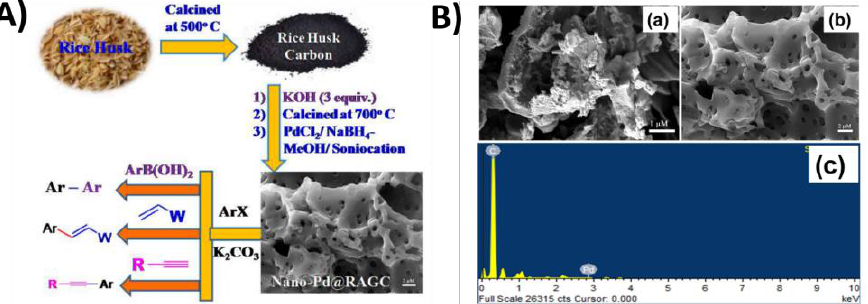
Figure 24. ( A ) Fabrication of nano-Pd@RAGC (from rice husk biomass-derived chemically activated mesoporous graphitic carbon) and its applications in cross-coupling reactions; ( B ) FESEM images of biomass-derived carbon ( a ) before KOH activation and ( b ) after KOH activation, and ( c ) FESEM- EDAX image of nano-Pd@RAGC. Adapted with permission from ref. [128].